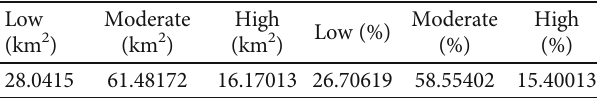
Figure 14: Map of common areas between the four methods. Table 16: Index vulnerability area in km 2 and %